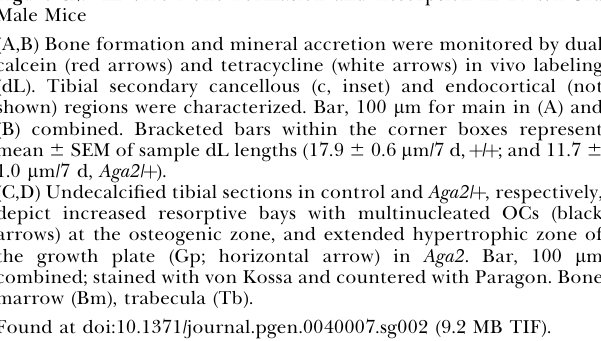
Figure S3. Quantitative Analysis of Physiological Bone Growth and Remodeling in 16-Wk-Old Male Tibiae (A) Percentage of secondary trabecular surface encompassed with OBs. (B) MAR calculated within both secondary cancellous (c) and endocortical (EC) bones, while BFR was calculated for mid-cancellous